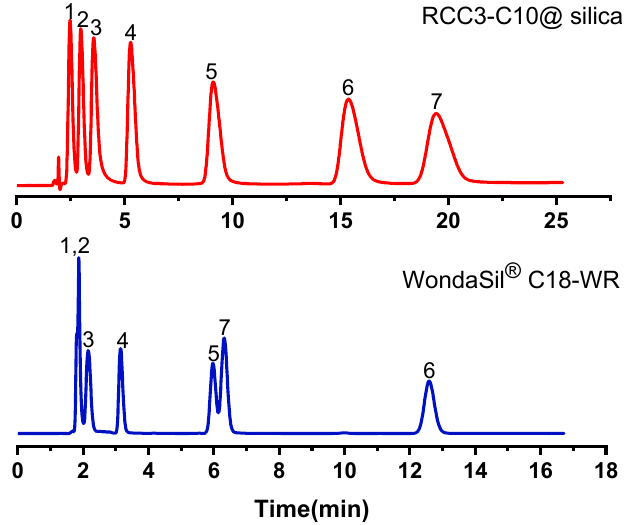
Figure 2. Chromatograms of phenol compounds on the RCC3-C10@silica column and WondaSil ® C18-WR column. Analytes: (1) p-aminophenol, (2) m-aminophenol, (3) o-aminophenol, (4) phenol, (5) 3, 5-dimethyl phenol, (6) p-tert-butyl phenol, (7) 2-naphthol. Mobile phase: 60% methanol/water ( v / v ); Flow rate: 1.0 mL/min; UV: 234